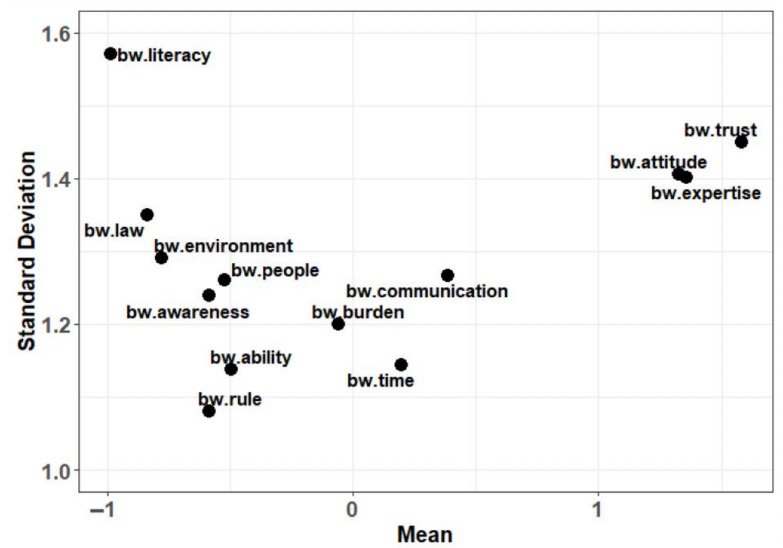
Figure 3. Plot of the mean and standard deviation of the best-worst score for each attribute (BW, best-worst).